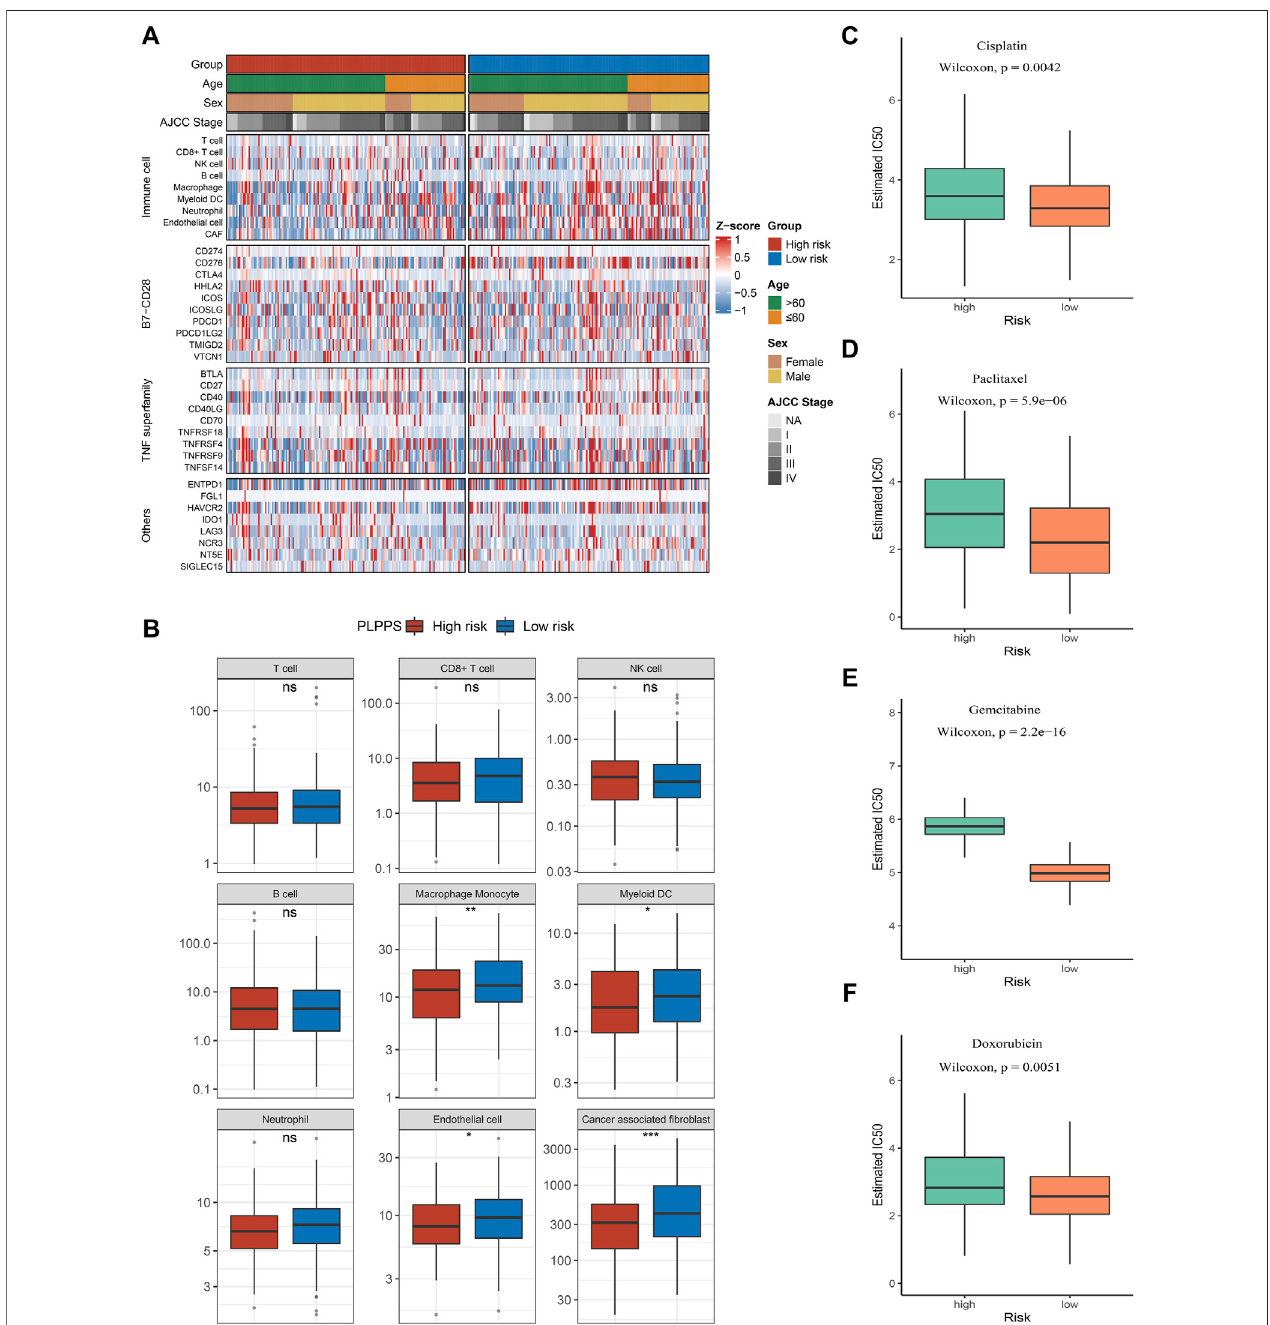
FIGURE 6 | Immune in fi ltration analysis and prediction of chemotherapy response in the two groups. (A) Heatmap for immune analysis among the two subtypes. (B) Boxplots of nine immune cell enrichment levels (C – F) . Sensitivity of cisplatin (C) , paclitaxel (D) , gemcitabine (E) , and doxorubicin (F) in the two subtypes.